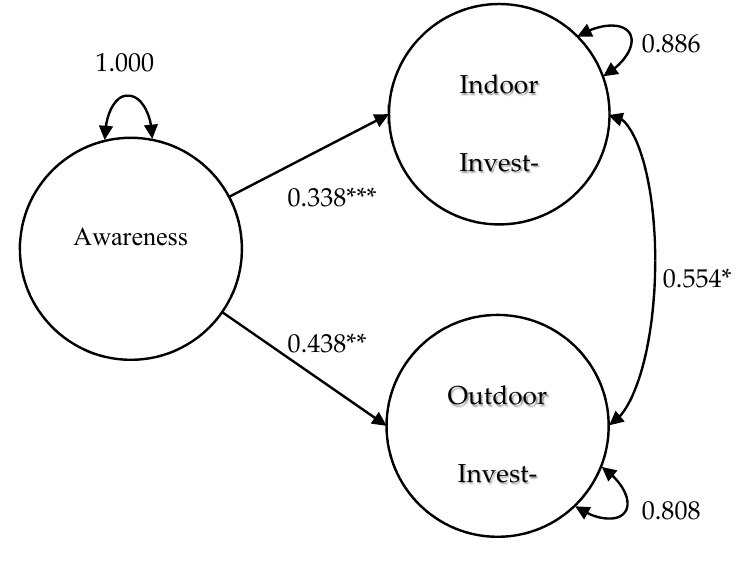
Figure 4. Model of owning water-saving appliances for indoor and outdoor usage regressed on awareness of water supplies for well owners ( n = 407).